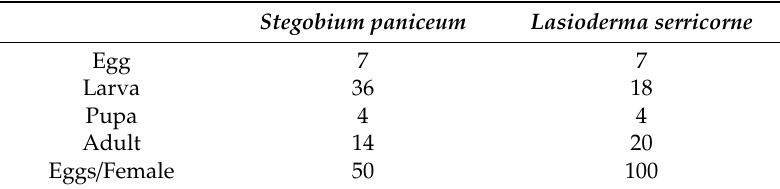
Table 1. Development time for